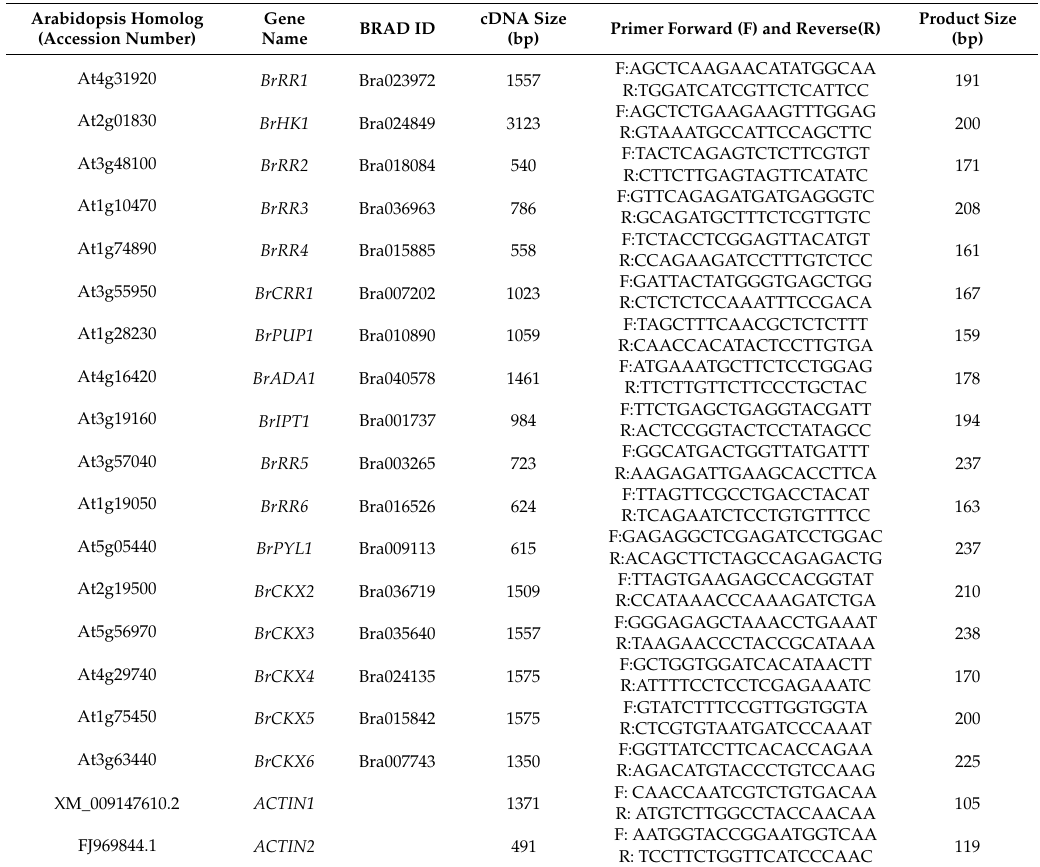
Table 4. List of primer sequences used for qRT-PCR of cytokinin-related genes. BrCRR1 is involved in protein phosphorylation and BrPYL1 is a receptor of